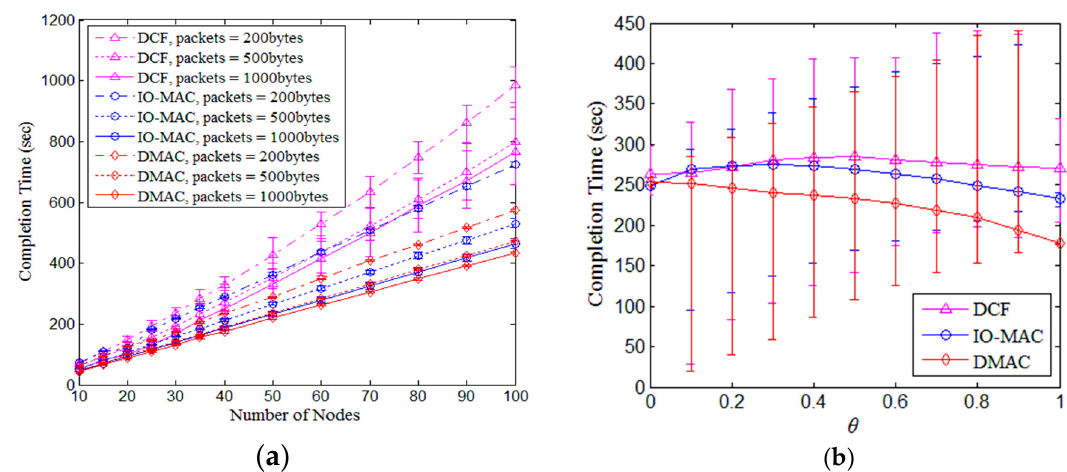
Figure 5. Delay in saturated and non-saturated scenarios. ( a ) Completion time in saturated scenario; ( b ) Completion time in non-saturated scenario.